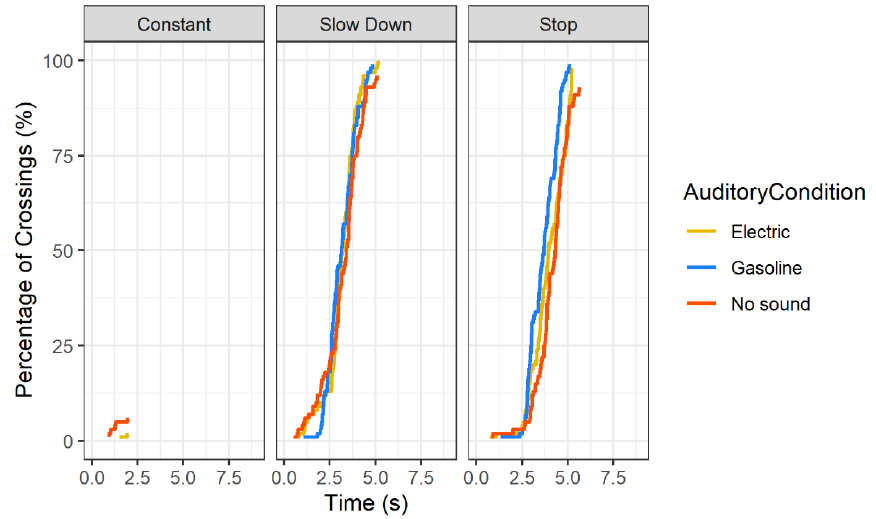
Figure 4. Percentage of cumulative crossings aggregated for all participants as a function of response time.